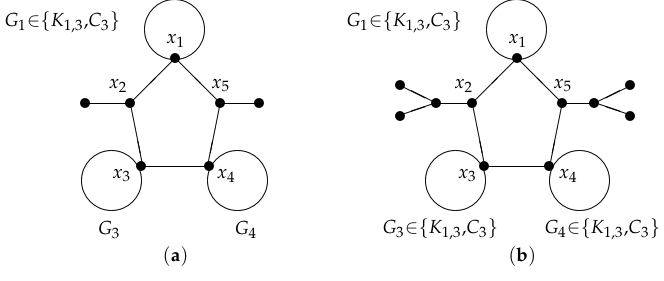
Figure 8. Illustrations of Theorem